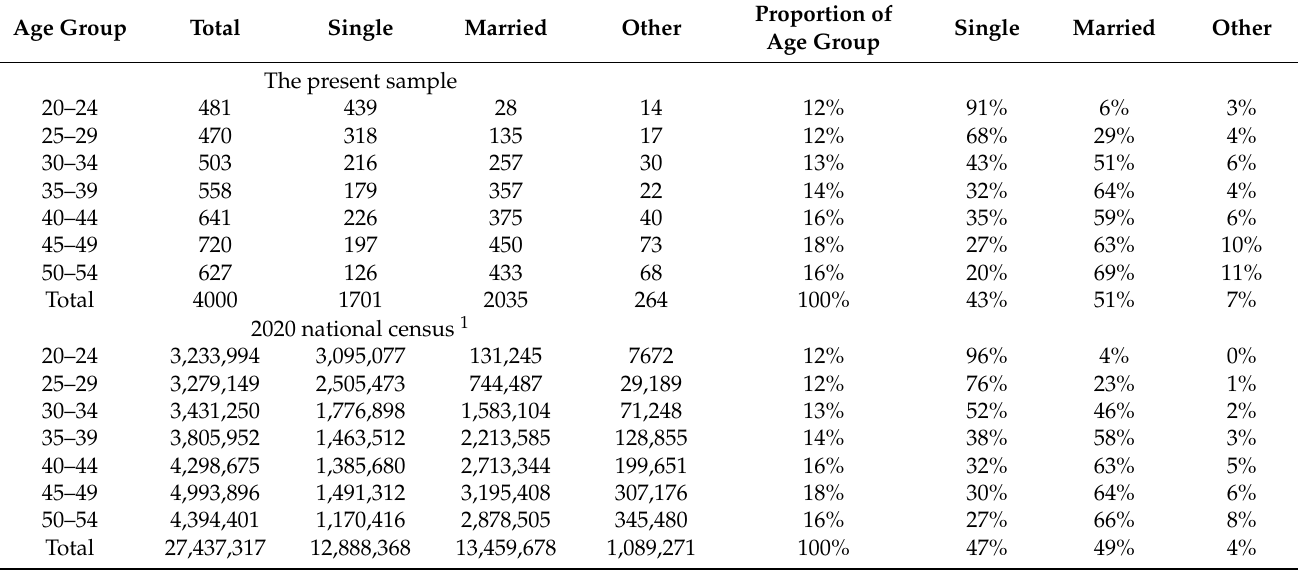
Table 1. Sample sizes by age group and marital status of the present sample and of the 2020 national census of Japan (male population